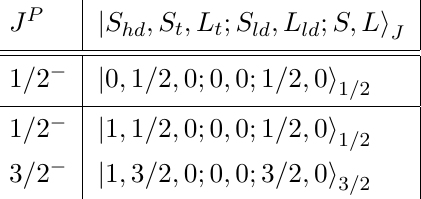
Table 3 . Spin-parity J P and state vectors of the S -wave pentaquarks containing the \bad" light diquark with the spin S ld = 1. The horizontal line demarcates the spin S hd of the heavy